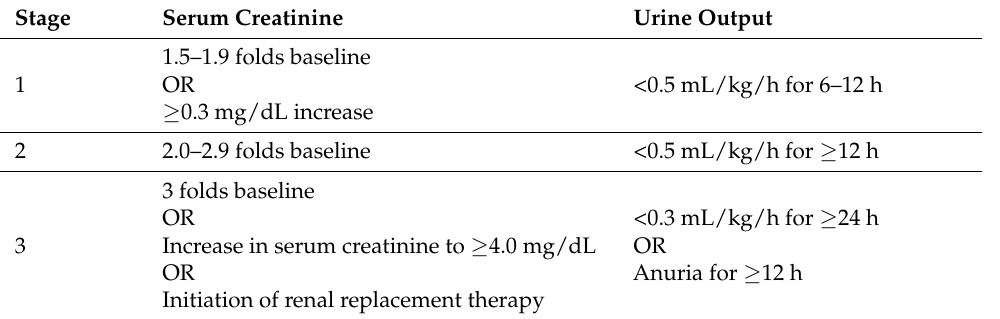
Table 1. Staging of acute kidney injury.